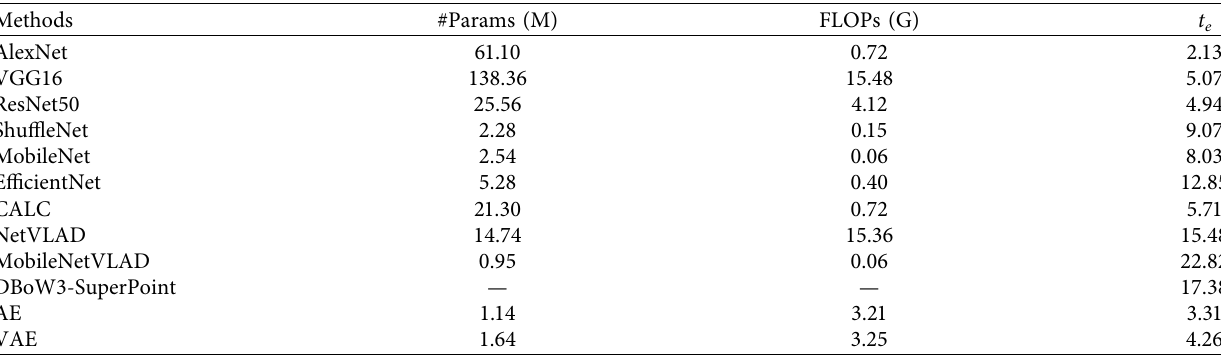
Table 7: Times (in milliseconds) for feature encoding t e (ms) of 12 CNN-based descriptors, using a GPU-based platform.